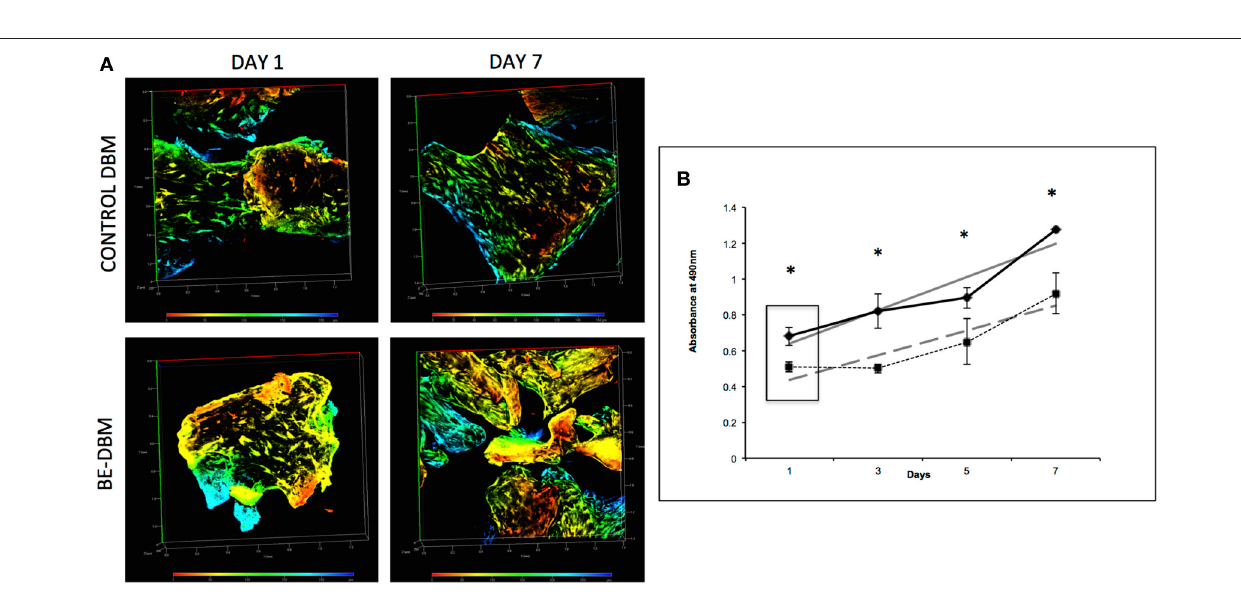
FIGURE 3 | Attachment and proliferation of HMSCs in DBM and BE-DBM. (A) Represents 3D renderings of z-stack confocal images of HMSCs within DBM and BE-DBM after 1 day and 1 week. These images provide qualitative proof that the BE-DBM promotes enhanced stem cell attachment and proliferation. The color-coding in the renderings represents depth as indicated by the depth scale below. (B) Represents proliferation of HMSCs in the DBM (dotted lines) and BE-DBM (solid lines) over 1 week. The data points represent mean of quadruplicates with standard deviation as error. The slope of the linear lines (dotted lines for DBM and solid lines for BE-DBM) provides the rate of proliferation. HMSCs in the BE-DBM showed a 34.52% increase in proliferation rate. The boxed region in the graph represents data obtained at day 1. A 34.07% ( P < 0.01 by student’s t -test) increase in initial cell attachment was seen in BE-DBM with respect to DBM. The data at